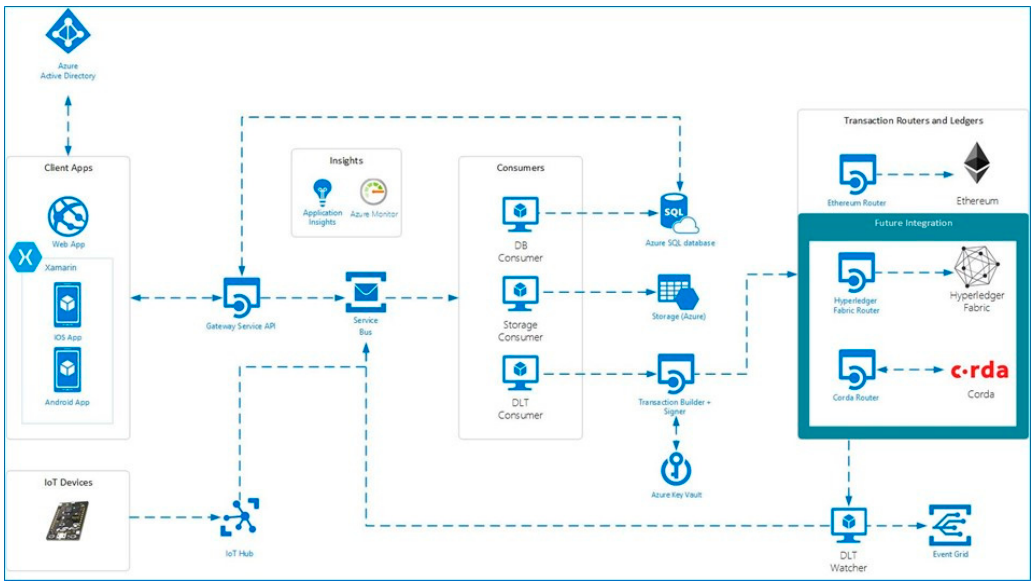
Figure 3. Azure workbench blockchain flowchart: list of activated services on Azure cloud and their connections.